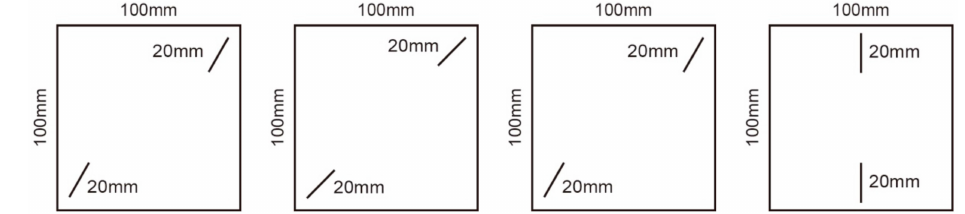
Figure 5. Schematic diagram of joint specimens in scheme IV.